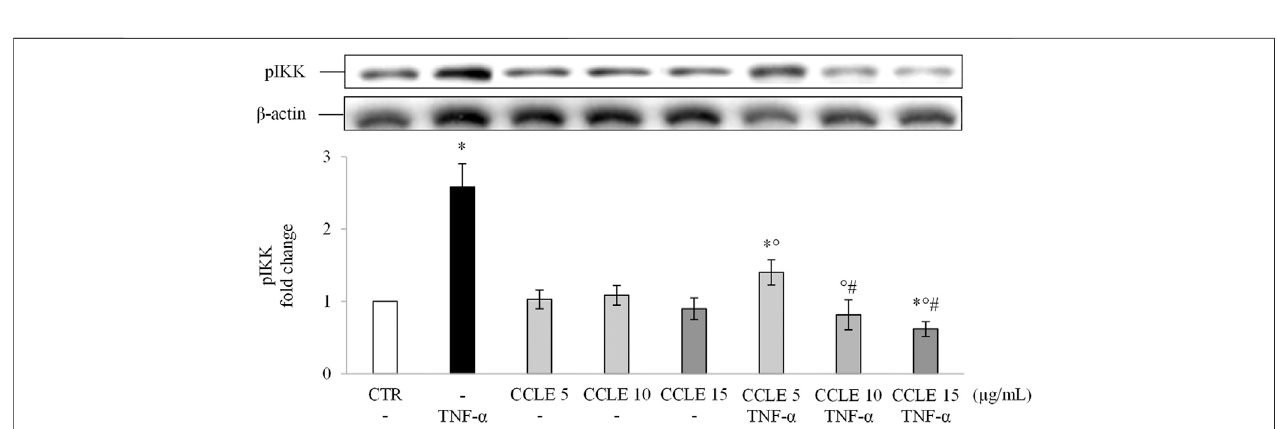
FIGURE 2 | pIKK α / β . The Caco-2 monolayer was pretreated with CCLE (5, 10, and 15 μ g/ml) for 24 h, and subsequently exposed to 50 ng/ml TNF- α for 6 h. Cultures treated with the vehicles alone were used ascontrols(CTR). pIKK α / β intensity values were normalized tothe corresponding β -actin value. Results are reported as fold change against CTR and expressed as mean ± SD of three independent experiments. * p < .05 vs CTR; ° p < .05 vs TNF- α ; # p < .05 vs CCLE 5 μ g/ml + TNF- α .